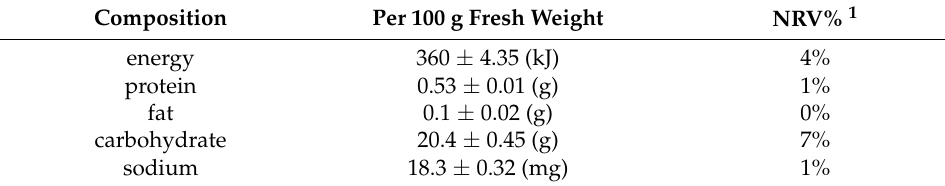
Table 6. Nutritional composition of the optimised citrus-based functional jelly.